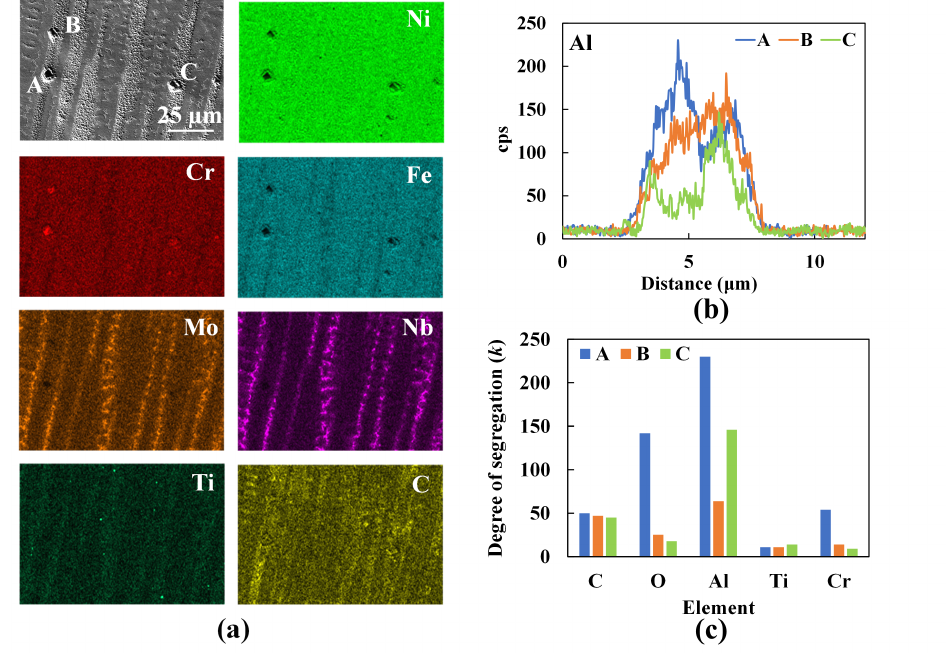
Figure 14. ( a ) EDS map of a representative region in the wire-fed specimen with three precipitates marked as A, B, and C where line scans are obtained. ( b ) EDS line profile of Al across the three marked regions. ( c ) Degree of segregation ( k ) of various alloying elements across the marked regions within the deposit.